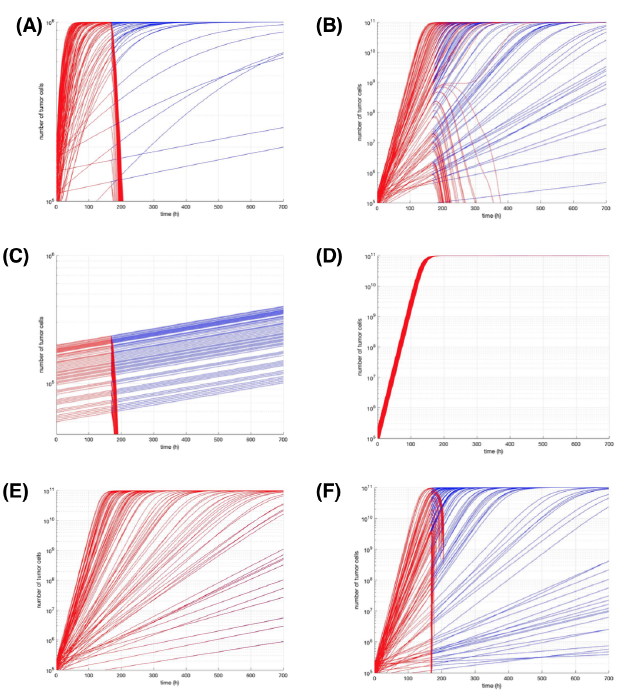
Figure 4. Hypothetical therapies results. The red curves represent the growth of tumor cells with immunotherapy and blue curves represent the growth of tumor cells without immunotherapy. Figure 4 all simulation result implements a therapy with infusion size of 10 7 DCs injected every 168 h by 3 weeks. The subfigures ( A , B ) using different carrying capacity with K = 10 6 and K = 10 11 respectively. For cases ( C , D ) is varied the rate tumor growth parameter in 0.001 and 0.1. The subfigures ( E , F ) the dendritic cells infused is varied in 10 3 and 10 9 every 168 h by 3